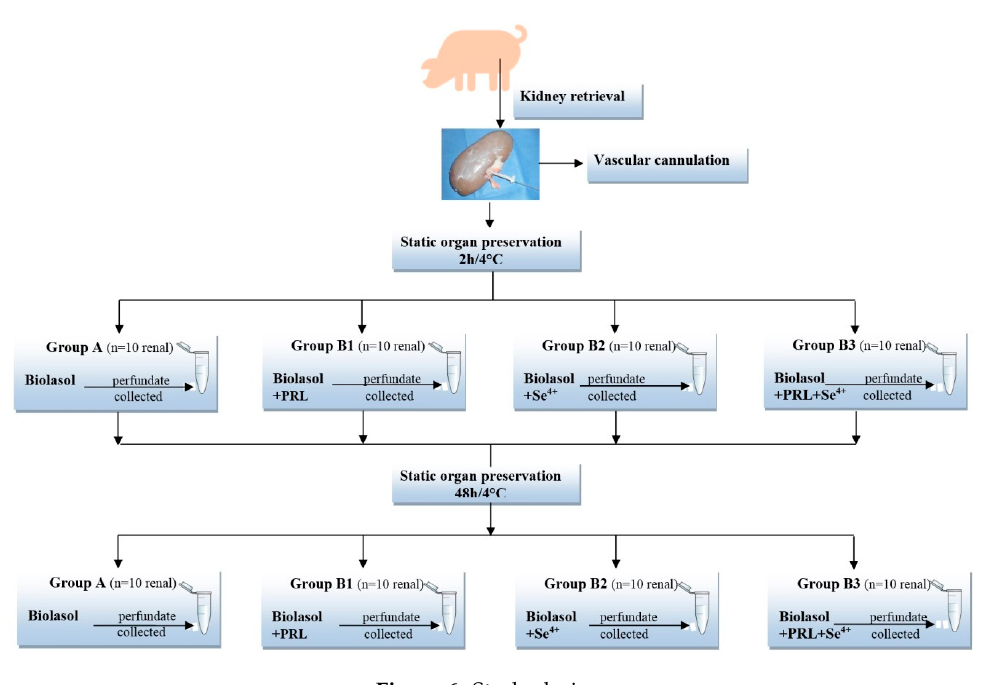
Figure 6. Study design.